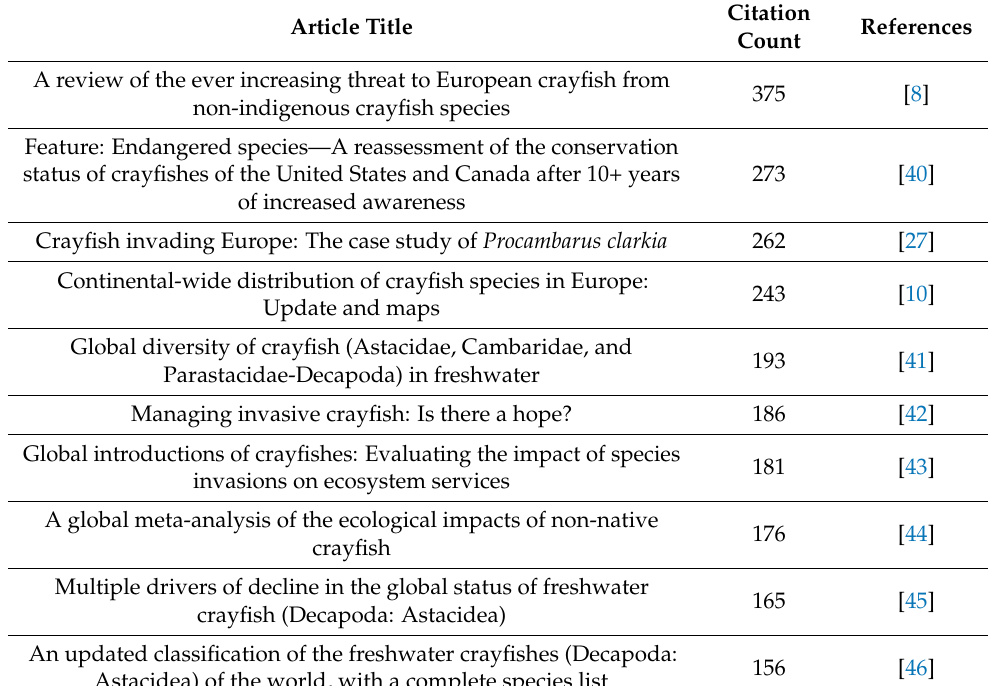
Table 4. Top 10 published articles and their citation counts related to crayfish research.